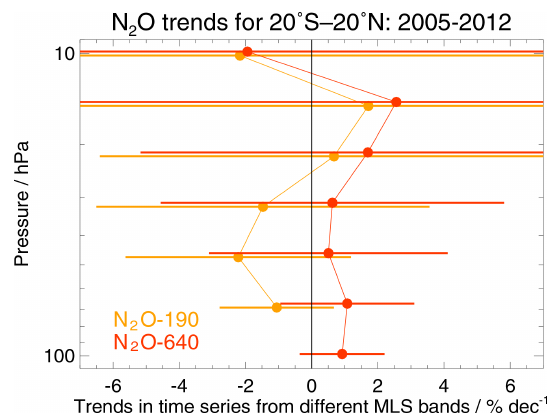
Figure 9. The 2005–2012 trend seen in MLS 190 and 640GHz trop- ical (20 ◦ S–20 ◦ N) N 2 O. Error bars are 2 σ intervals estimated from block bootstrapping.